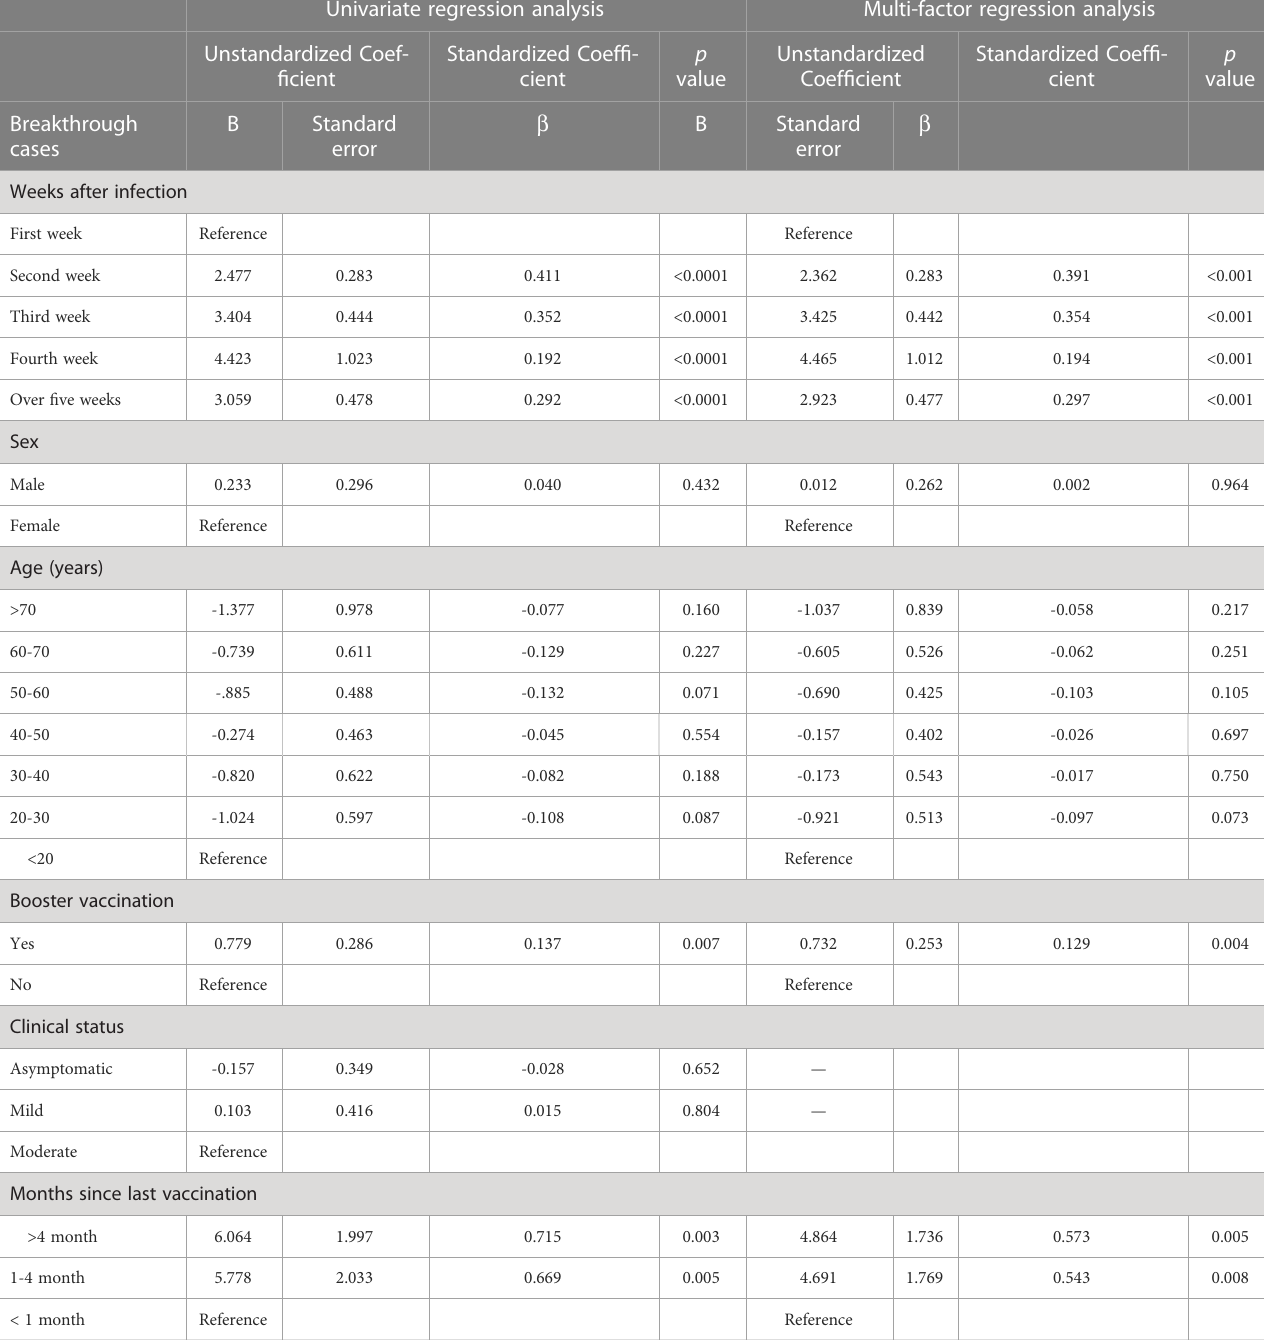
TABLE 3 Linear regression of the factors in fl uencing NAb levels in the breakthrough